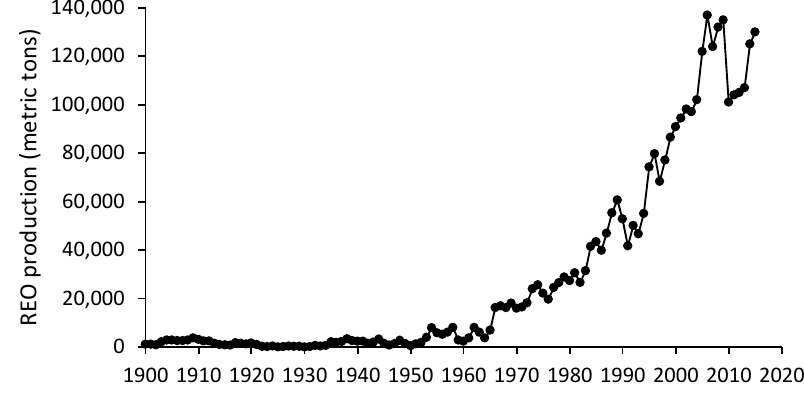
Figure 1. Global rare-earth oxide (REO) production [43].